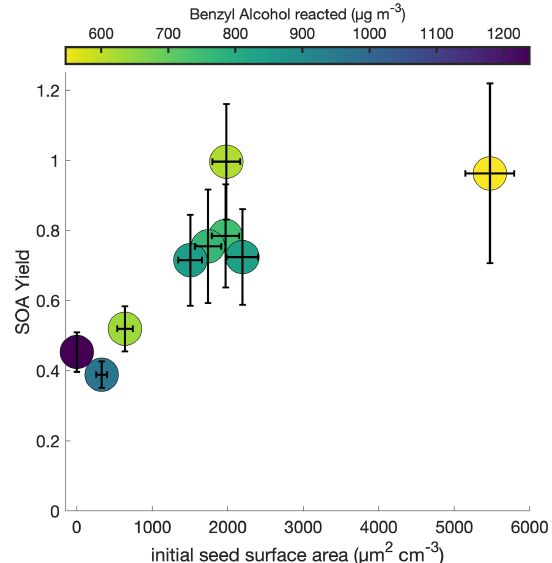
Figure 2. Variation in observed benzyl alcohol SOA yield with an initial NO mixing ratio of 80ppb at 291K as a function of the amount of benzyl alcohol reacted and the initial aerosol seed surface area. The lack of a difference in the yield over differing seed sur- face areas above ∼ 1800µm 2 cm − 3 indicates that the experiments lie within a regime where the seed surface area does not affect the measured SOA